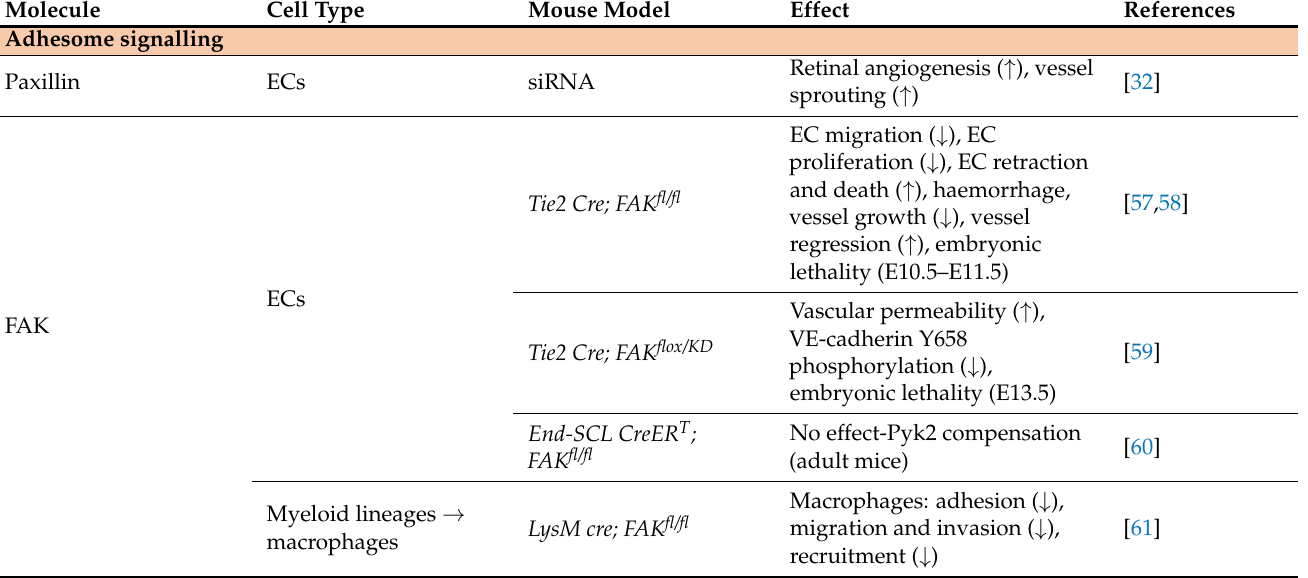
Table 2. Adhesome and physiology: in vivo studies describing the effect of deletion of adhesome members in specific cell types that participate in tumour microenvironment. Abbreviations: HSCs, hematopoietic stem cells.